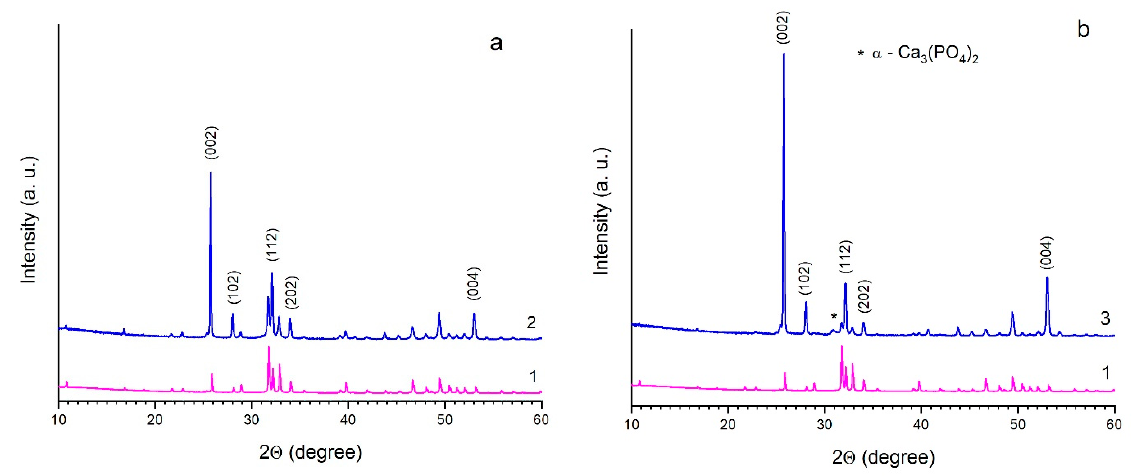
Figure 9. PXRD patterns of HA pellets after sintering at 1000 ◦ C in a high-temperature furnace (1) in comparison with PXRD patterns of HA pellets after treatment by a 0.2 mm laser spot at 4 W and different scanning speeds: ( a )—500 mm/s (2); ( b )—200 mm/s (3).